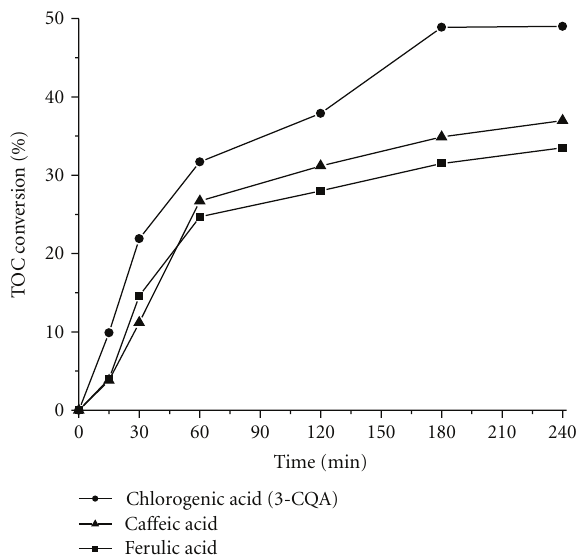
Figure 3: Total organic carbon (TOC) conversion with AlFe-PILC.